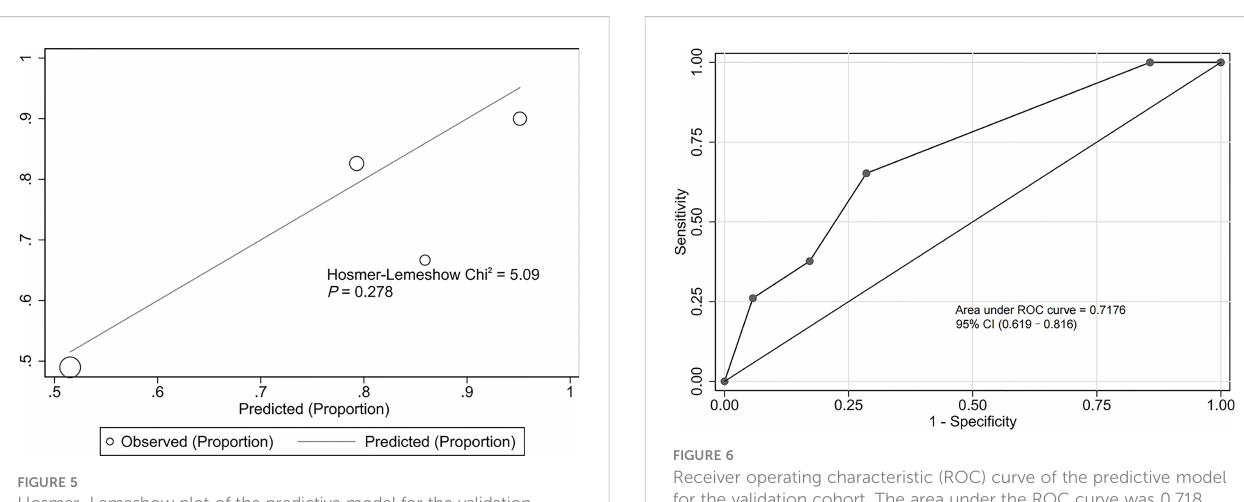
FIGURE 5 Hosmer − Lemeshow plot of the predictive model for the validation cohort. Assessment of the goodness of fi t using the Hosmer − Lemeshow test showed an c 2 value of 5.09 and a p -value of 0.278, suggesting that the model presented a good fi t in the validation cohort.